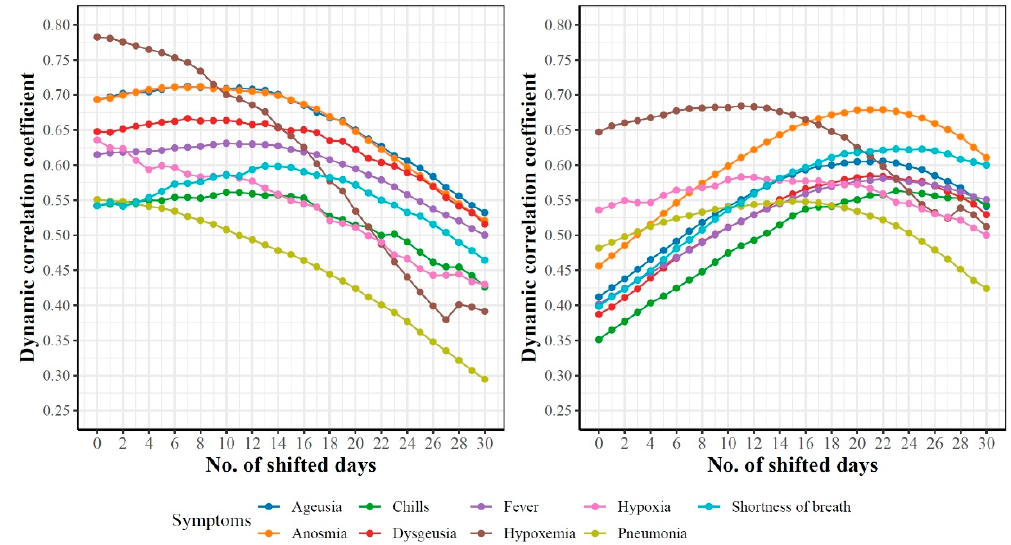
Figure 14. Dynamicity of the pairwise associations between the trajectories of nine symptoms and k-days ahead trajectories of COVID-19 cases ( left ) and deaths ( right ).